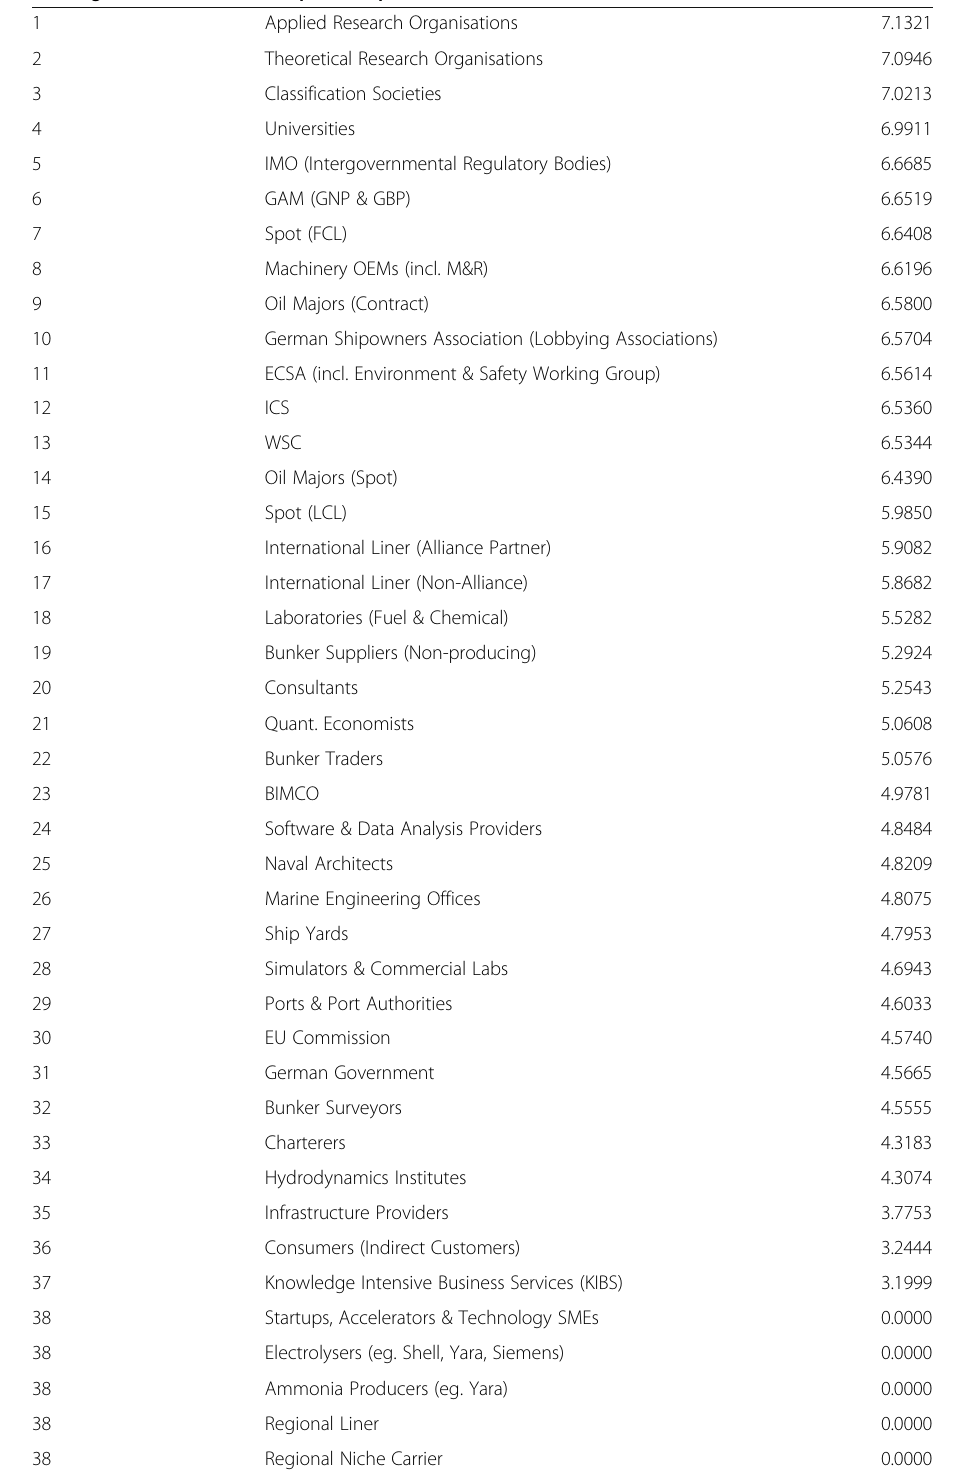
Table 2 Cooperation partner